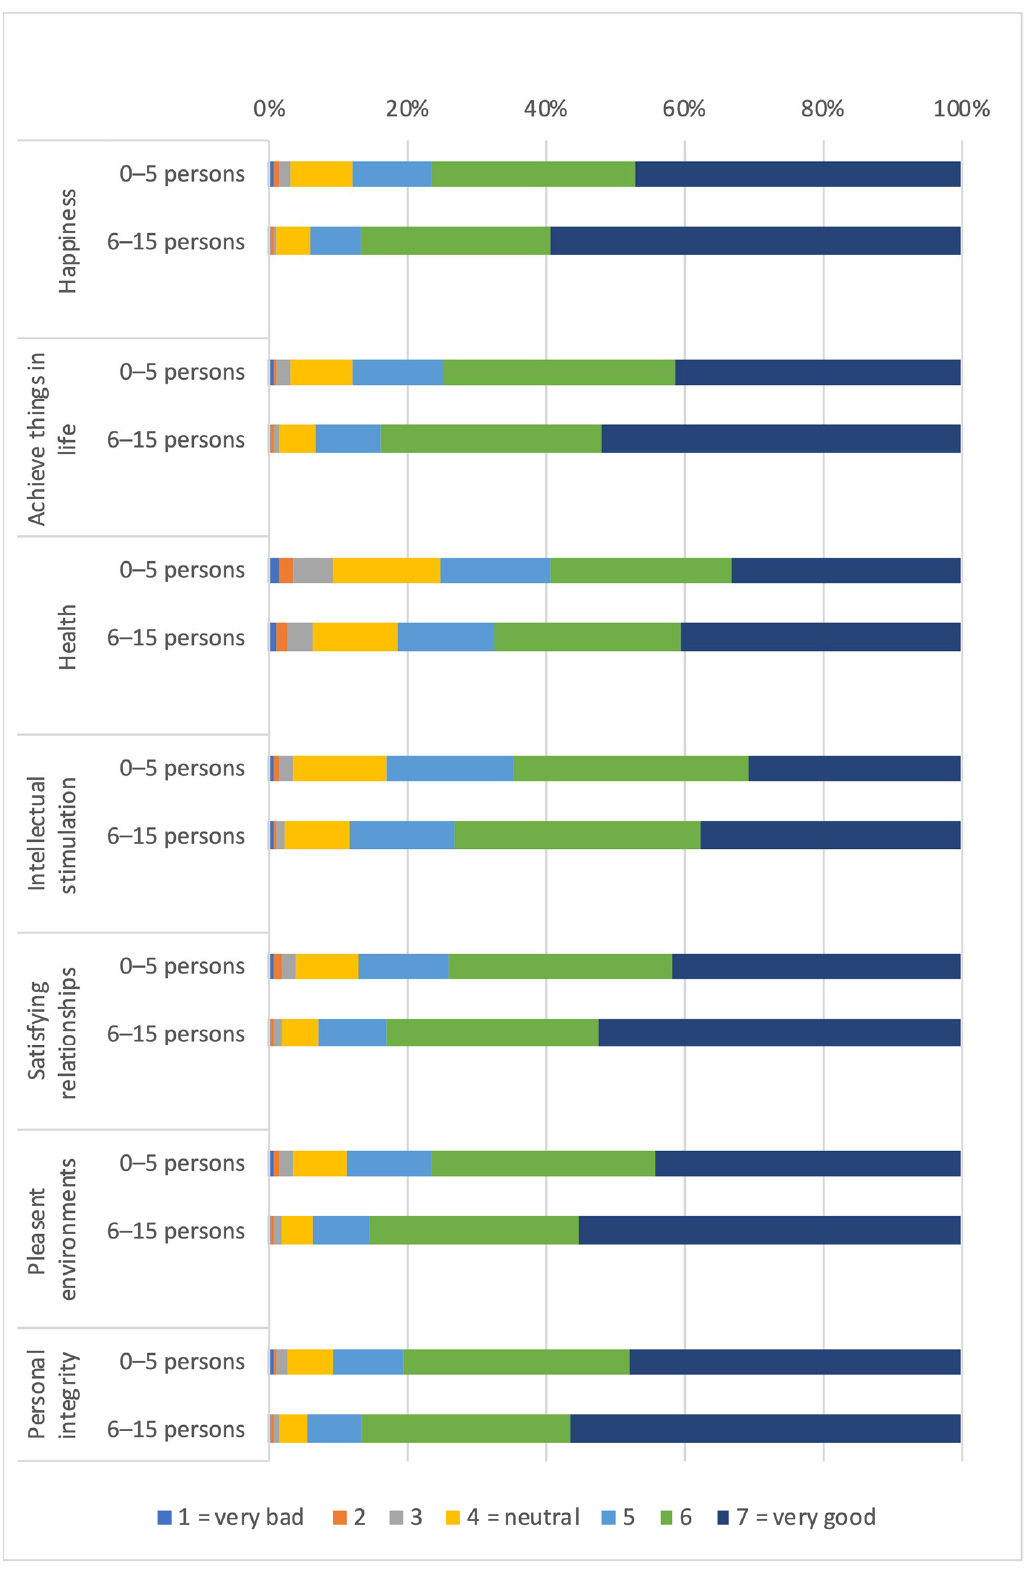
Figure 3. Distribution of capabilities and functionings according to number of persons to borrow CHF 500 from (social capital). ( a ): Distribution of capabilities; ( b ): Distribution of